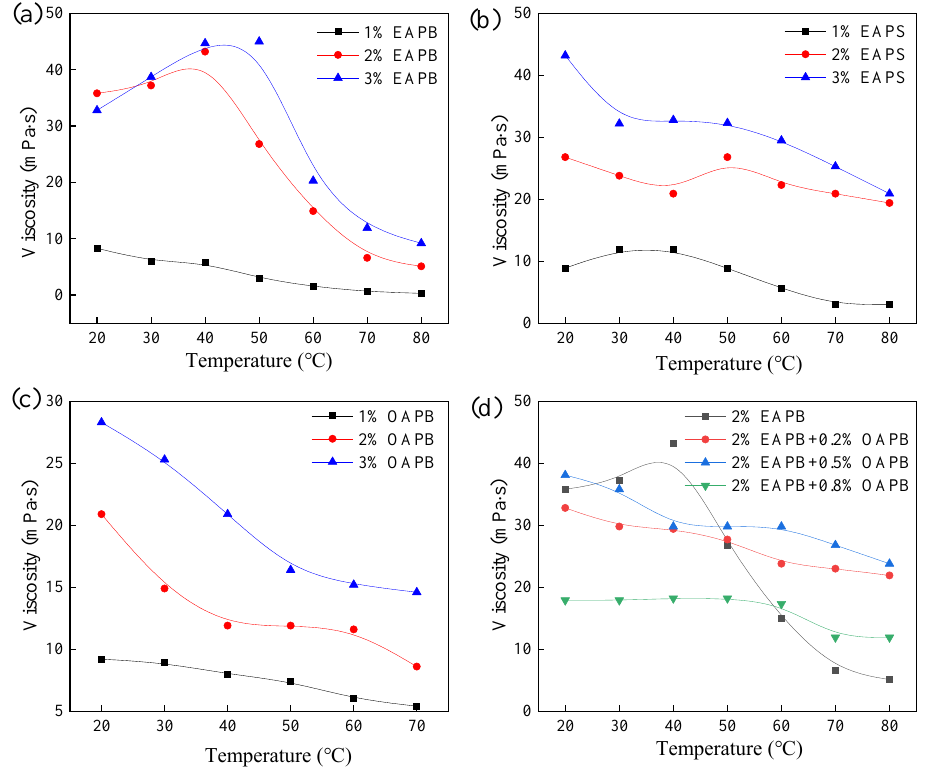
Figure 5. Apparent viscosity of surfactant solutions at different concentrations and temperatures: ( a ) EAPB; ( b ) EAPS; ( c ) OAPB; ( d ) EAPB + OAPB. All tested shear rates were 100 r min −1 .